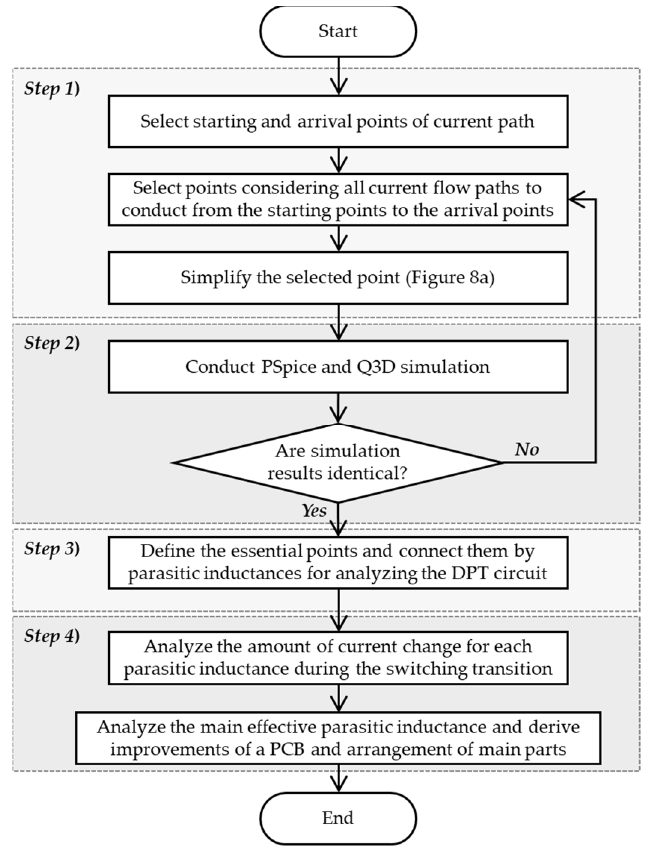
Figure 5. Flow chart of proposed power loop analysis technique.